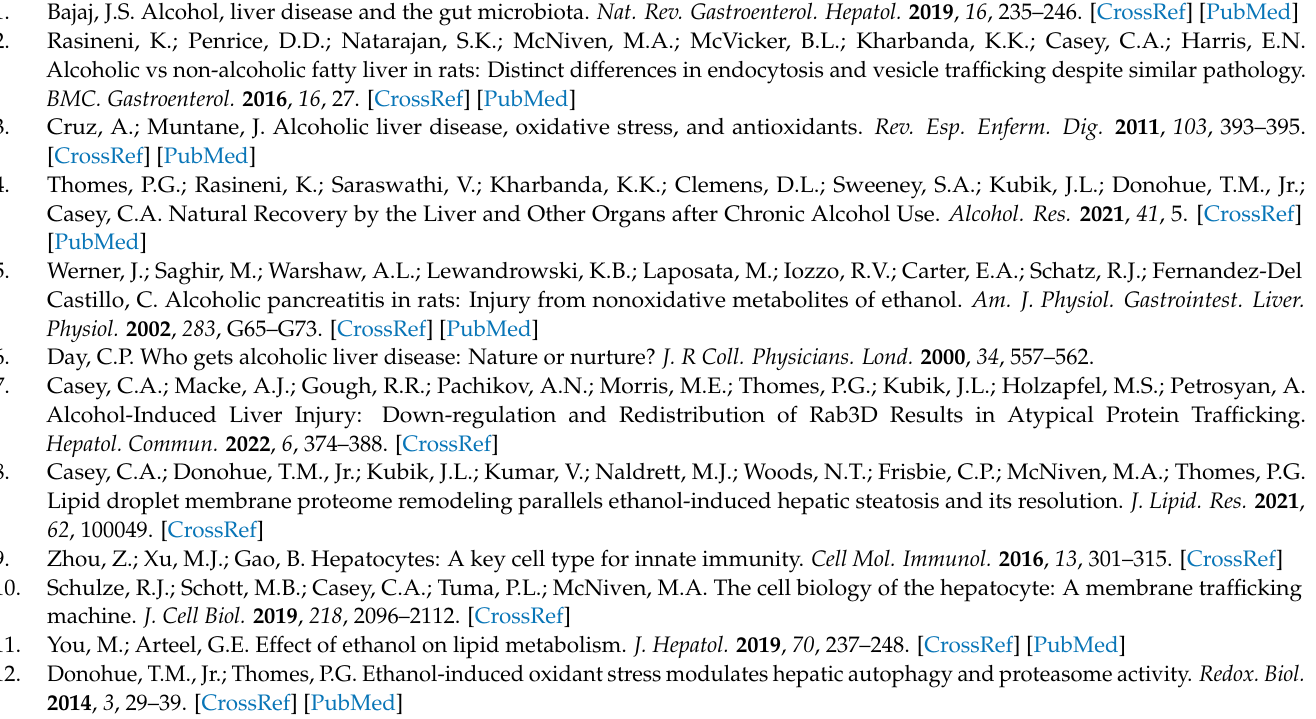
cytes cells isolated from control and EtOH-fed rat livers; Figure S4: Boxplot of the relative amounts of the Cpt1A protein detected in hepatocytes cells isolated from control and EtOH-fed rat livers for the PCA and OPLS-DA models, Table S2: Summary of the top-enriched metabolites from the LC-MS and NMR datasets; Table S3: Summary of the top-enriched lipids from the LC-MS dataset; Table S4: Enriched pathway analysis of proteomics dataset using KEGG; Table S5: Enriched pathway analysis of proteomics dataset using